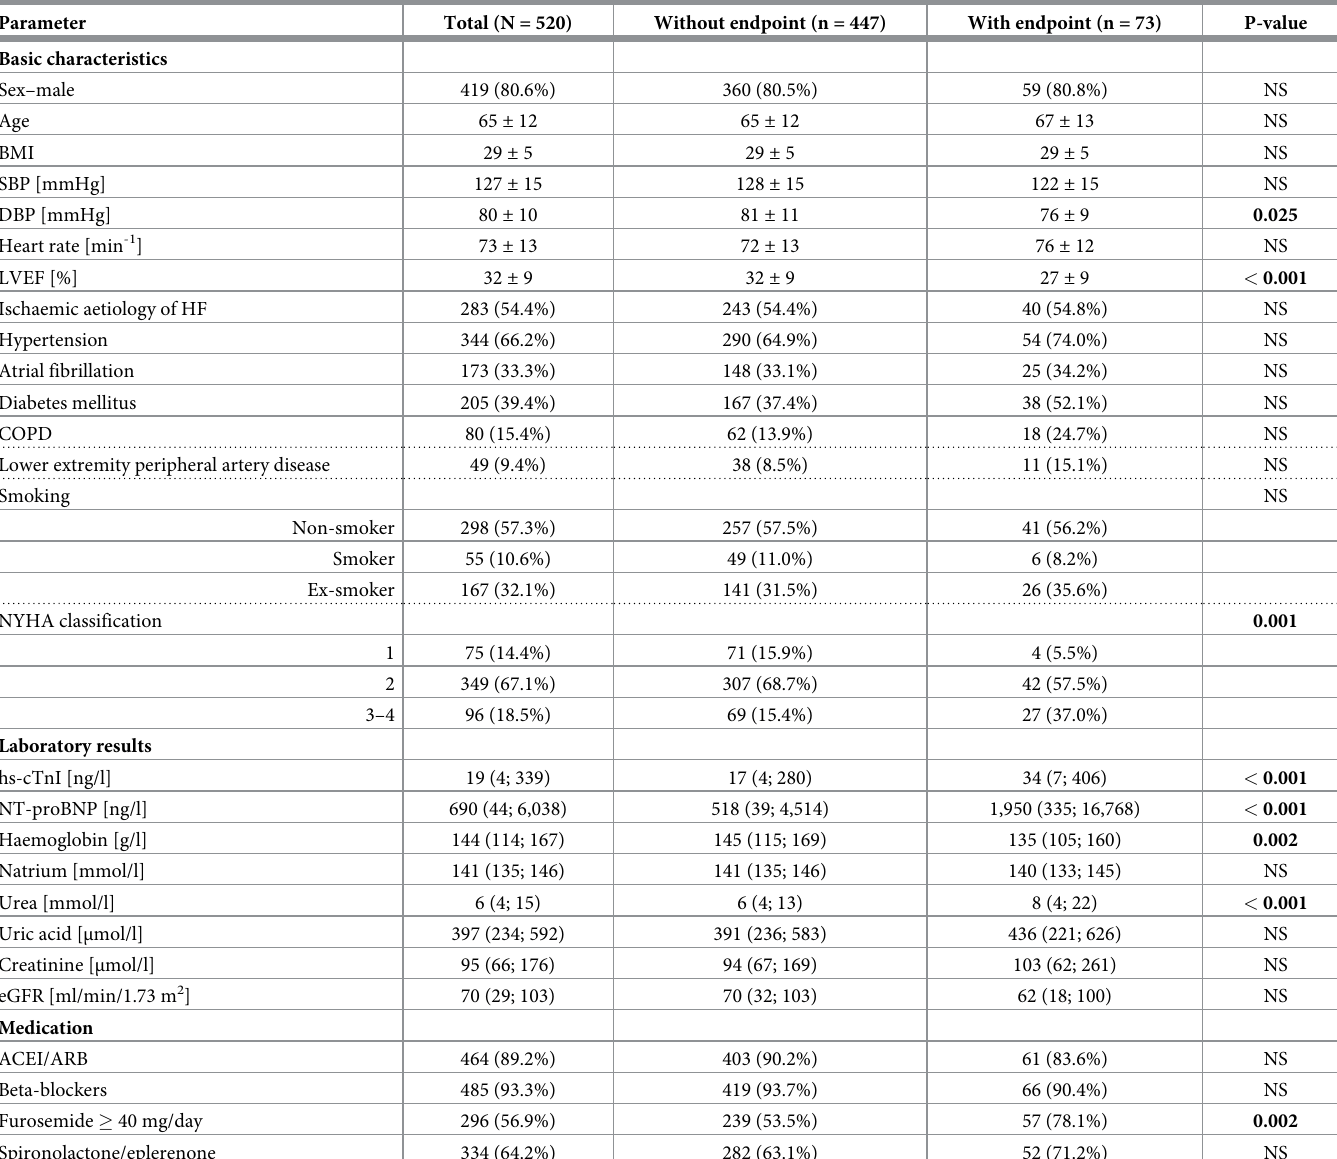
Table 1. Basic characteristics of the patients by occurance of the primary